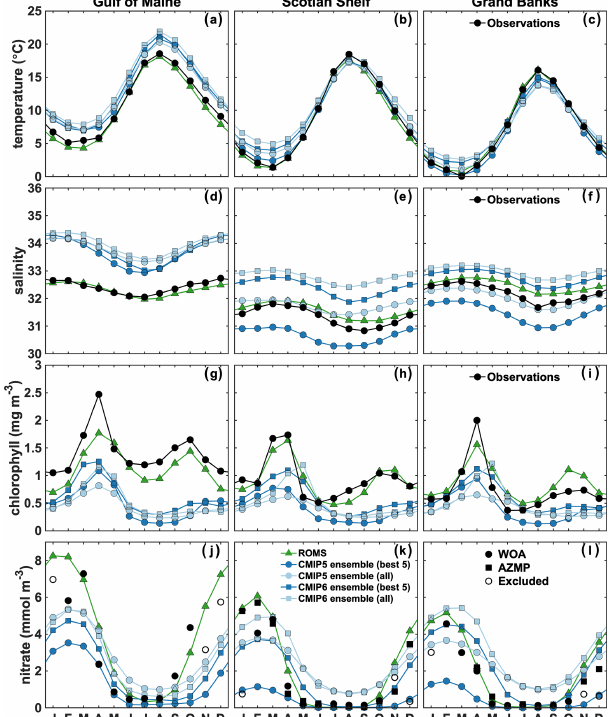
Figure 4. Observed, ROMS and ensemble means’ area-averaged surface temperature (a–c) , salinity (d–f) , chlorophyll (g–i) and ni- trate (j–l) in the NWA shelf regions. November–January WOA ni- trate data are excluded (open circles). Model comparison with ob- servations in the Gulf of Maine is therefore only available from February to October. For the Scotian Shelf and Grand Banks, ad- ditional AZMP data are available. In the case of multiple observa- tions, the data are monthly